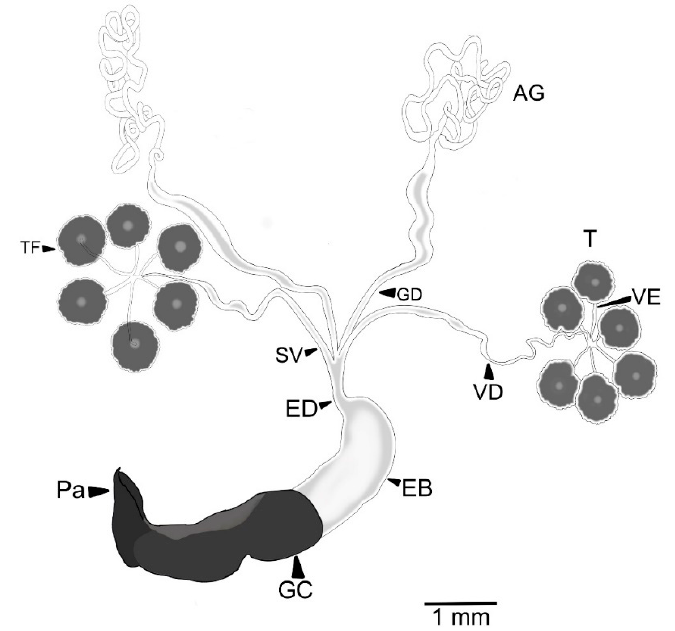
Figure 1. Reproductive apparatus of 18 d old Cyclocephala barrerai male. AG = accessory glands, GD = glandular duct, T = testes, TF = testis follicles, Vd = vasa deferentia, Ve = vasa efferen- tia, Sv = seminal vesicle, ED = ejaculatory duct, EB = ejaculatory bulb, GC = genital capsule, Pa =